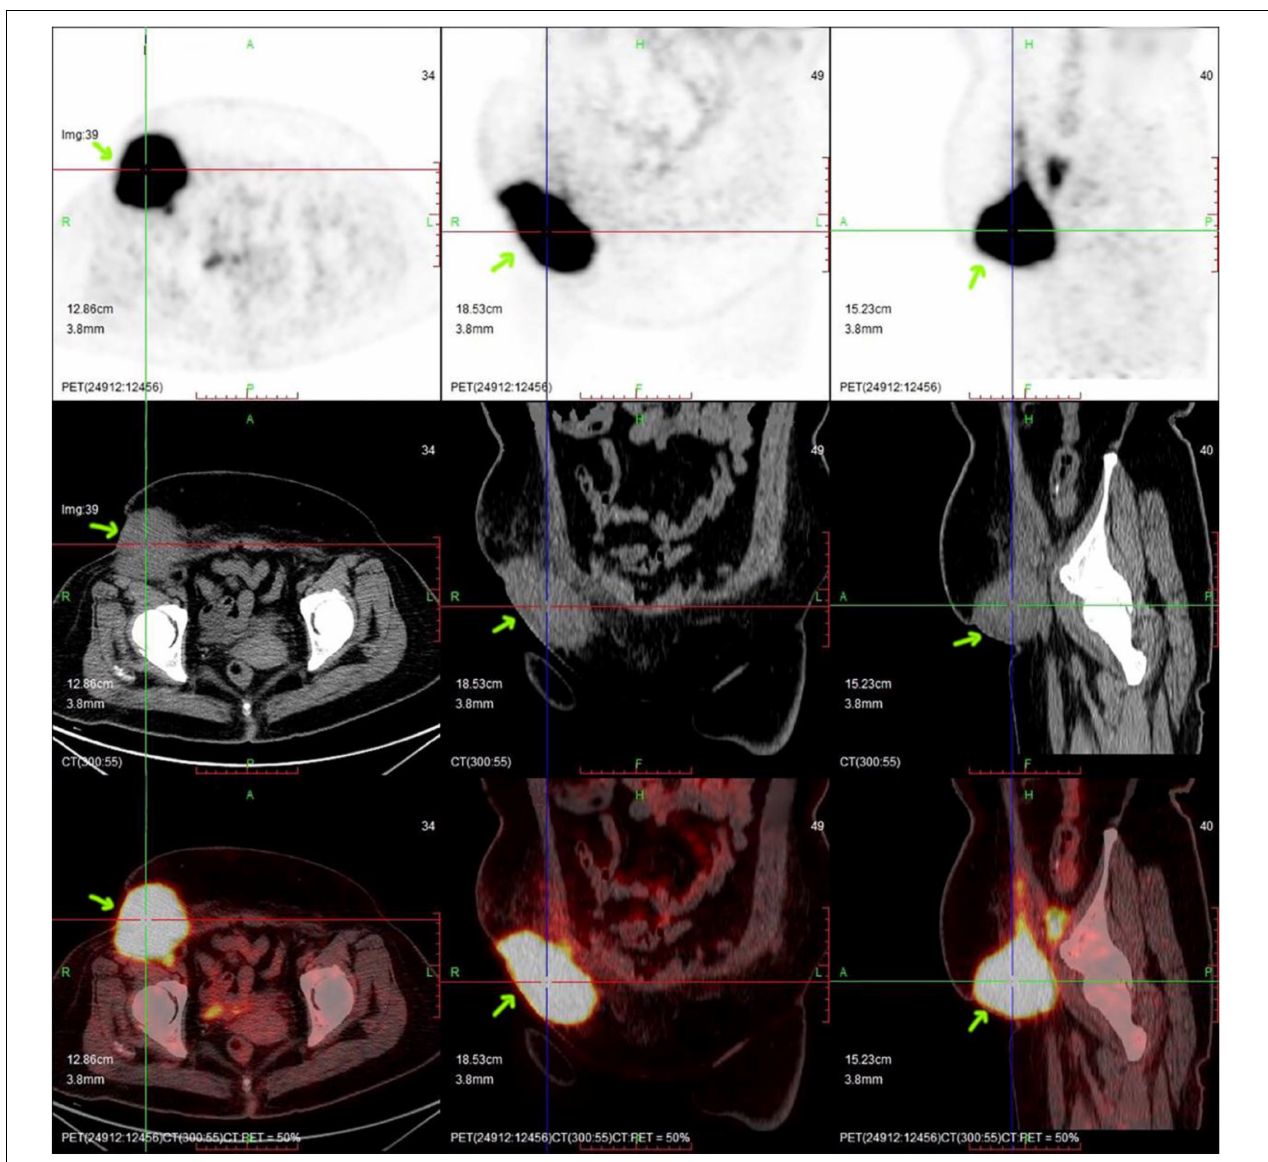
FIGURE 2 | PET/CT imaging before CAR-T cell infusion. The position indicated by the arrow is the location of the lesion, which had a volume of ∼ 71 mm × 72 mm × 98 mm